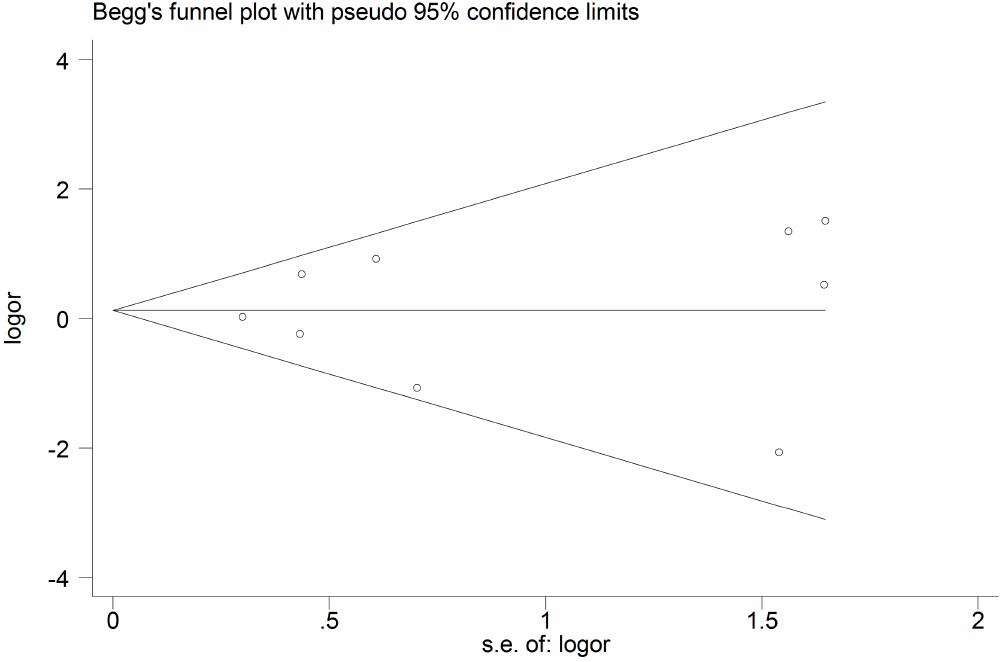
Fig 5. Funnel plot of the prevalenceof “large CSP” in the FEP